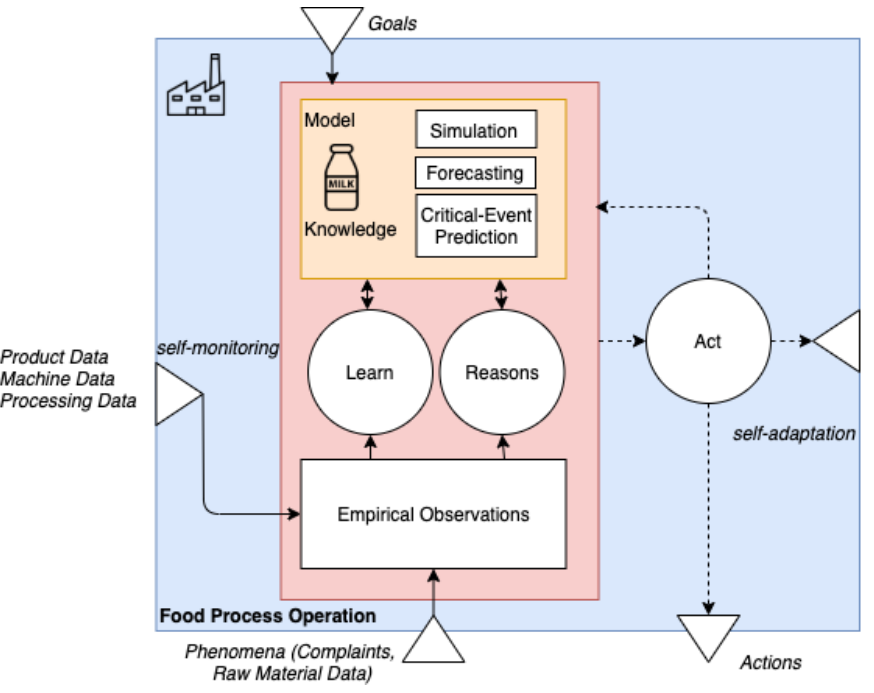
Figure 3. Conceptual framework on how to include data provided by a digital food twin into a self-aware learning and reasoning loop (based on